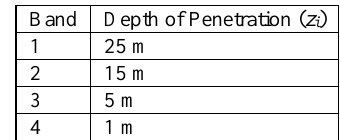
Table 1. Maximum depth of penetration by